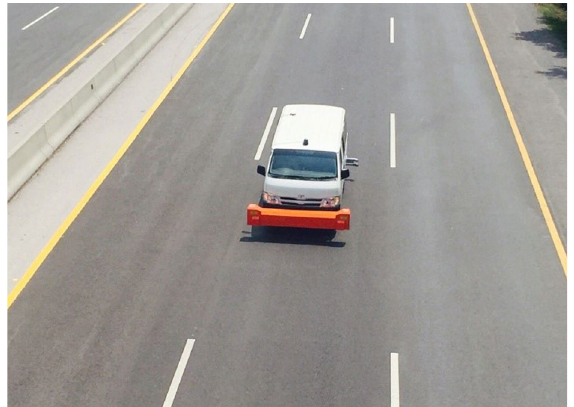
Fig. 3. Pavement roughness data collection using instrumented vehicle